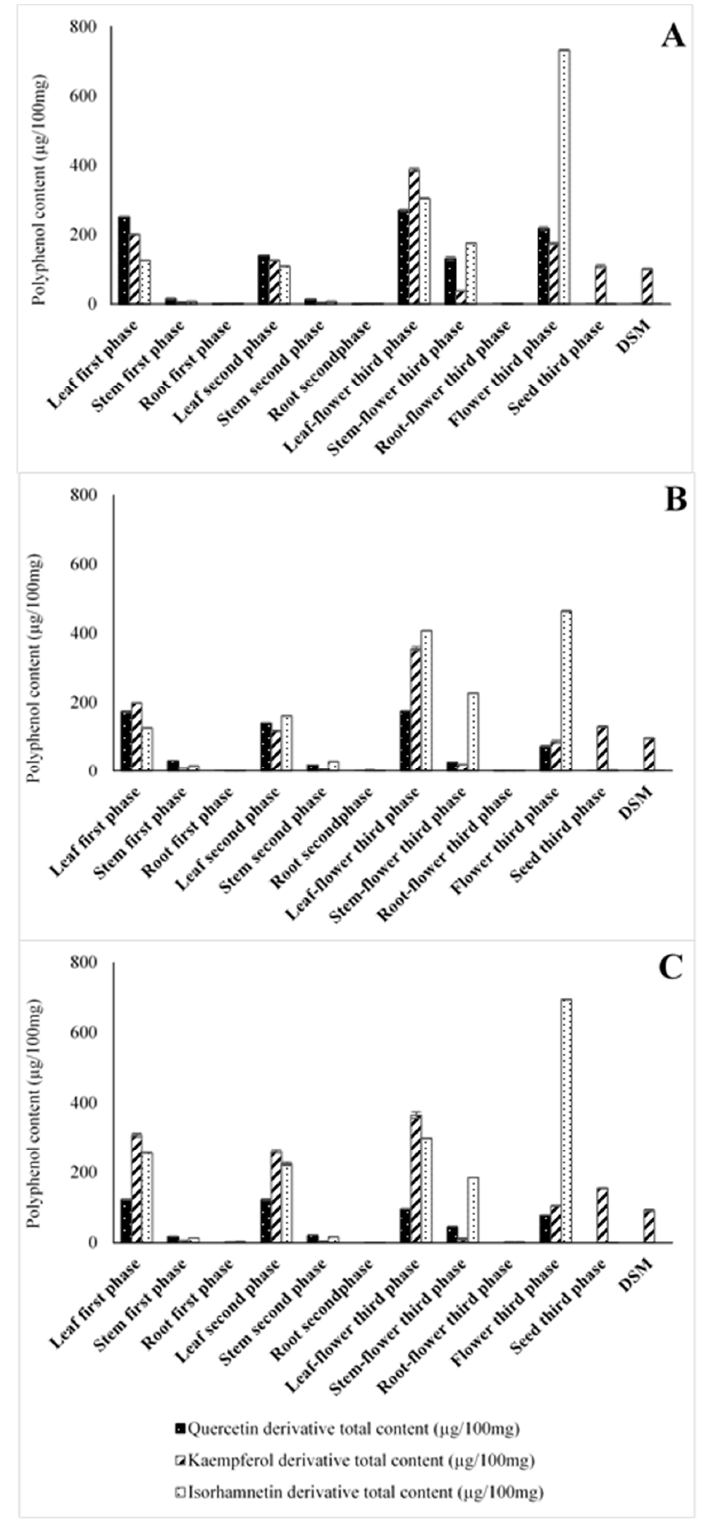
Figure 2. Polyphenol total content in (µg/100 mg DW) of different portions of three accessions of B. juncea . ( A ) B. juncea ISCI 99; ( B ) B. juncea ISCI Top; ( C ) B. juncea ISCI “Broad-leaf”.